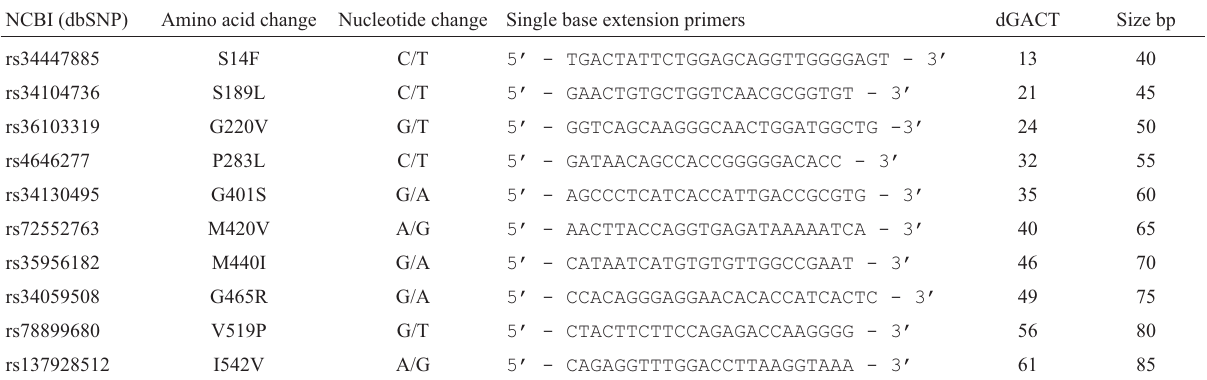
Table 2 - OCT1 multiplex 1 single base extension